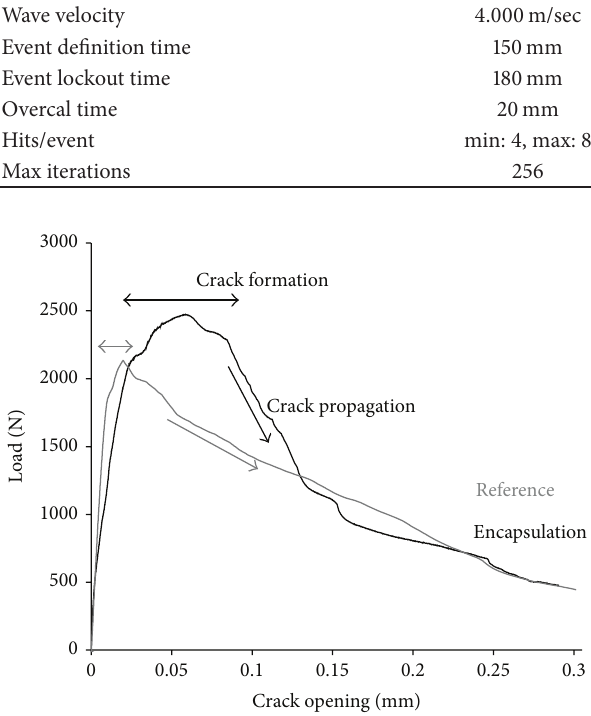
Figure 6: Load-crack opening graph for a representative sample of the reference and encapsulation